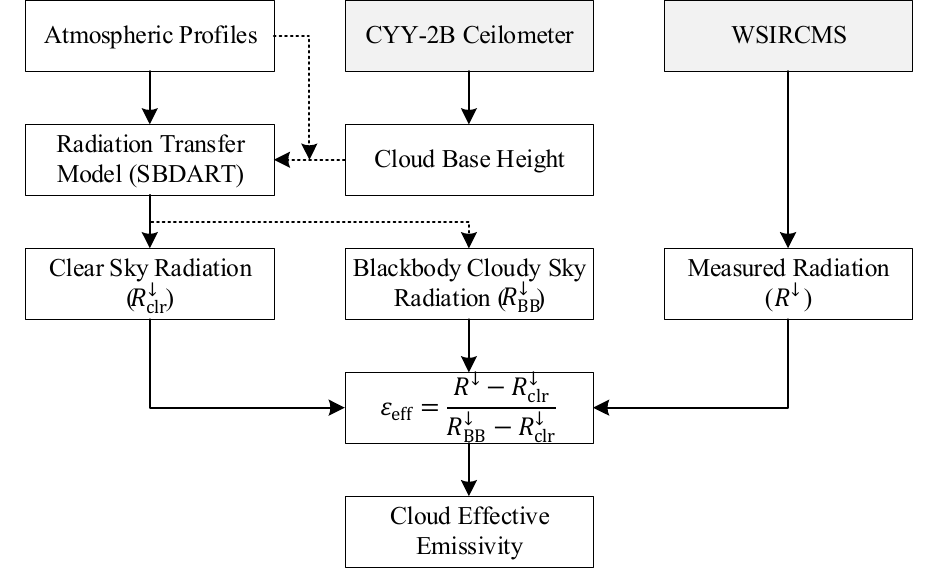
Figure 1. The cloud effective emissivity retrieval algorithm flow diagram.